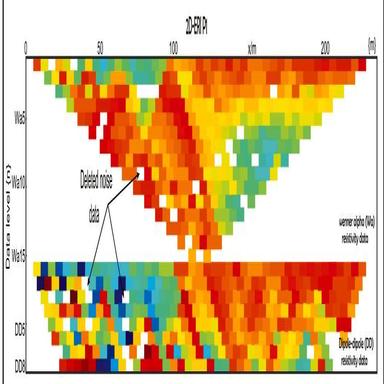
Resistivity pseudo-sections from the joint (Wa) and (DD) data set of 2D-ERI P1 (for location, c.f.).